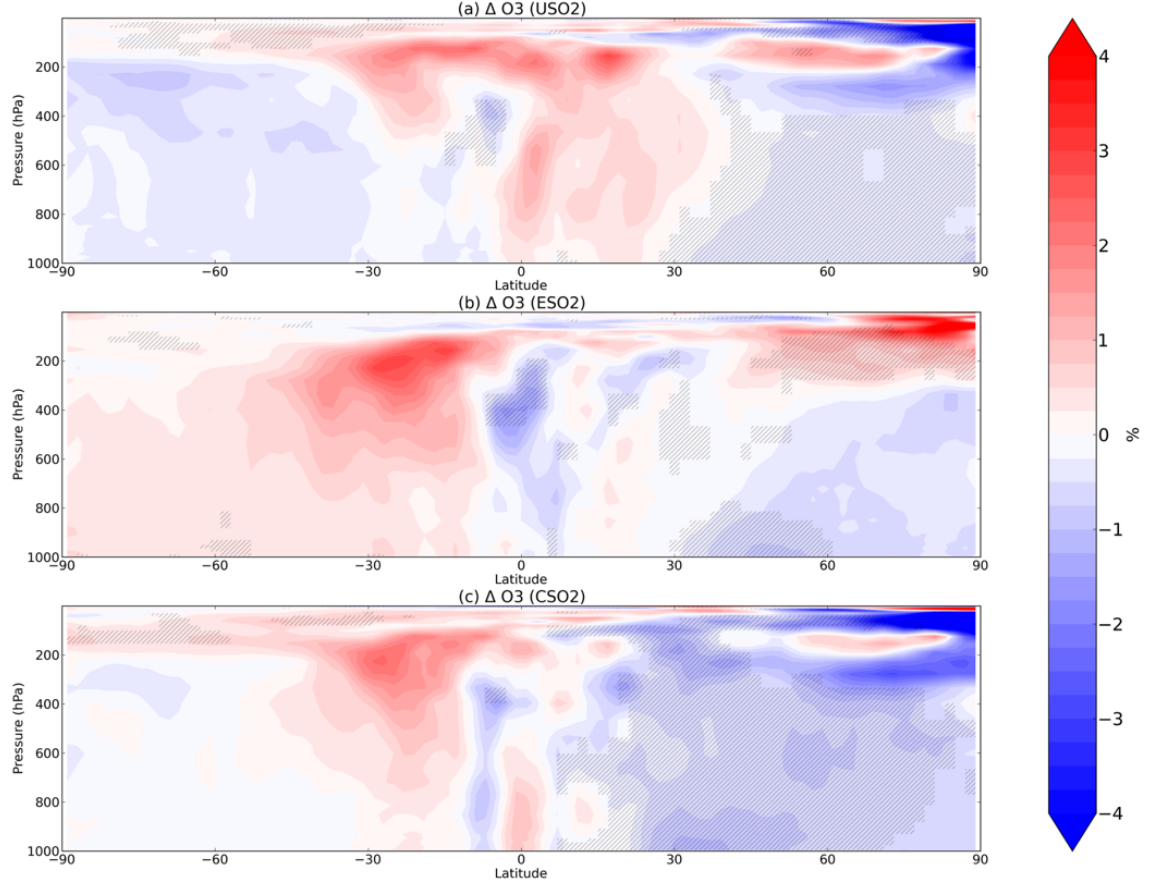
Figure 4. Boreal springtime (MAM) mean percent change in O 3 between a control simulation and a perturbation simulation in which anthropogenic SO 2 emissions are removed over a certain region: (a) US, (b) Europe, and (c) China. Hatching denotes statistical significance according to a Student’s t test at the 95% confidence